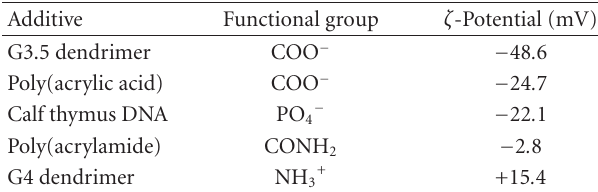
Table 1: Surface electric ζ -potential measured for microcrystals grown in the presence of di ff erent